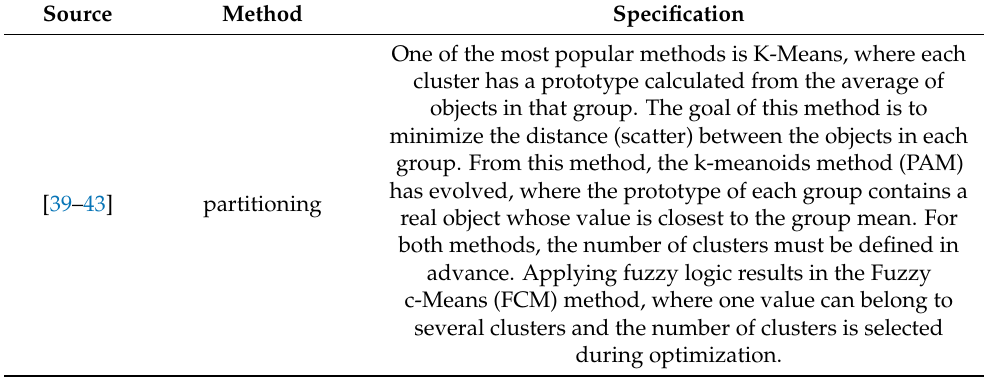
Table 3. The methods of cluster